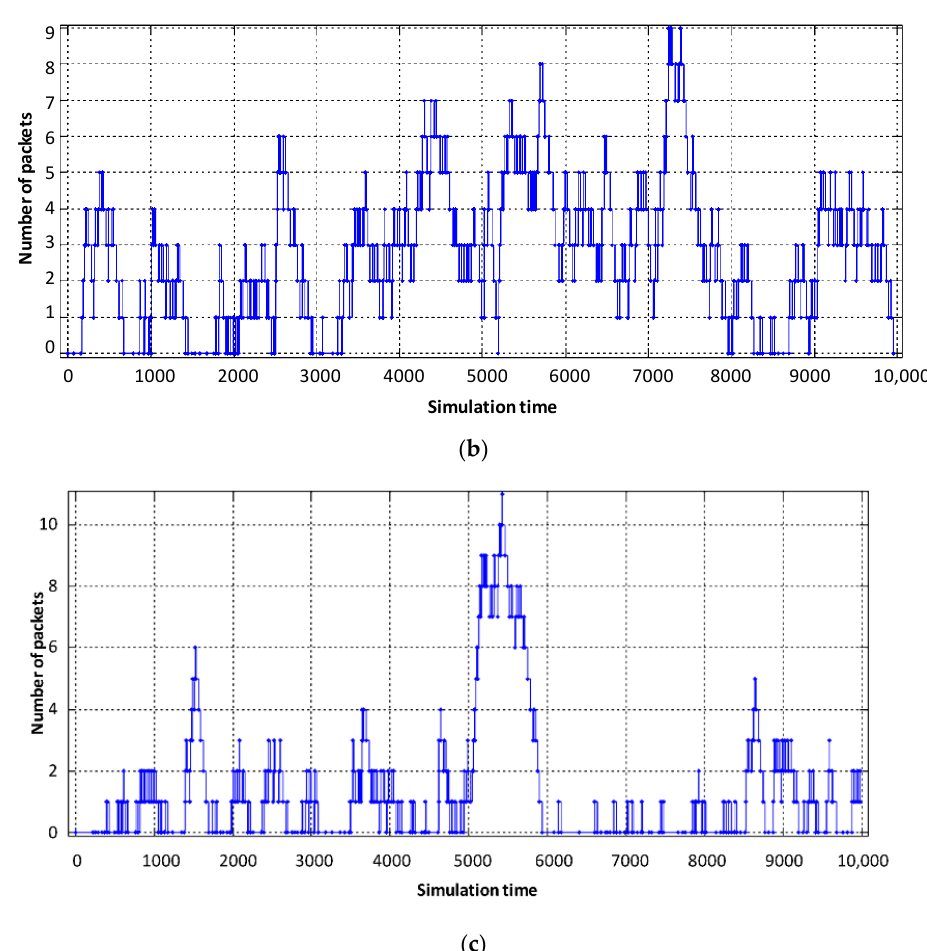
Figure 9. Loading the virtual router buffer with flows: ( a ) video, ( b ) voice, ( c ) data.